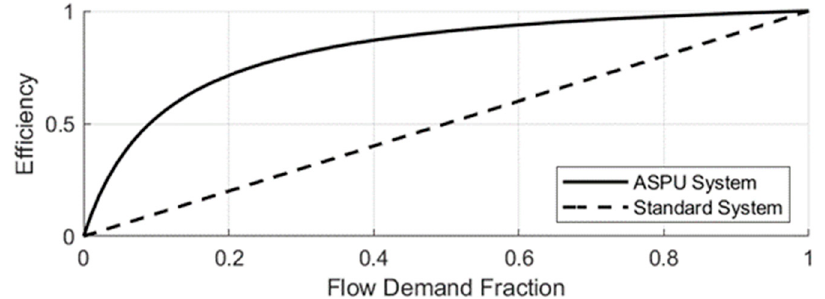
Figure 5. Efficiency comparison of ASPU and standard LP systems. Figure 5. E ffi ciency comparison of ASPU and standard LP systems.